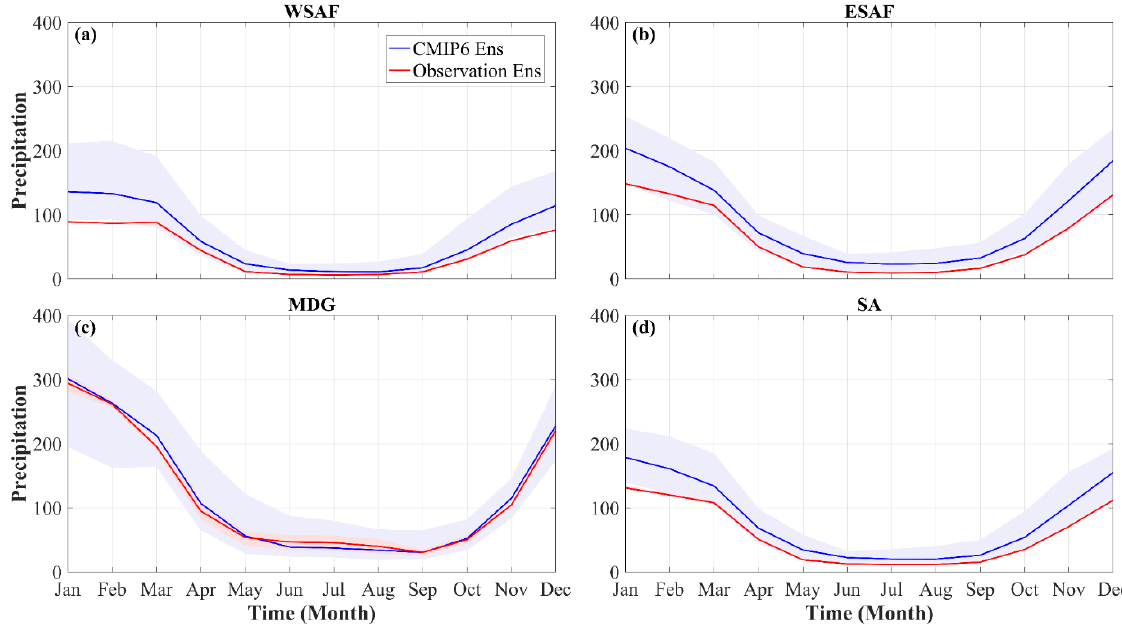
Figure 2. Annual variation of 1901–2014 precipitation (mm/month) averaged over ( a ) WSAF; ( b ) ESAF; ( c ) MDG; and ( d ) SA. The blue and red lines are the CMIP6 and observation ensemble, respectively. The blueish and reddish shadings are the spread of the individual datasets about the CMIP6 and observation ensemble, respectively.